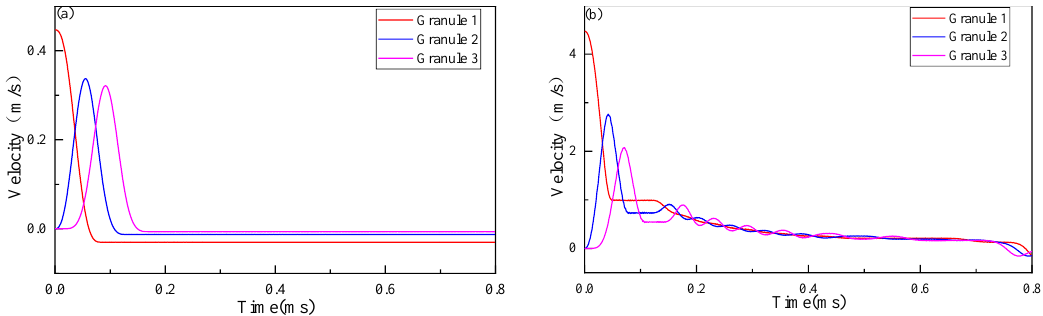
Figure 4. Velocity-time curves of the first three granules: ( a ) Homogeneous elastic granular chain; ( b ) Homogeneous elastic – plastic granular chain ( λ = 1).